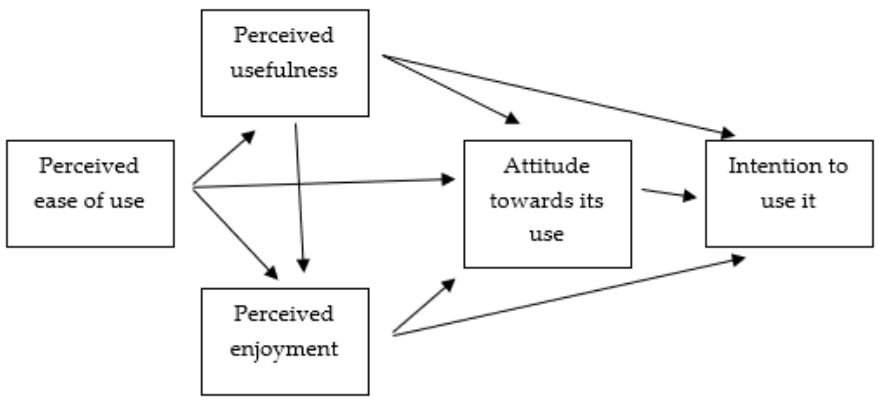
Figure 1. TAM model developed by Davis [28].